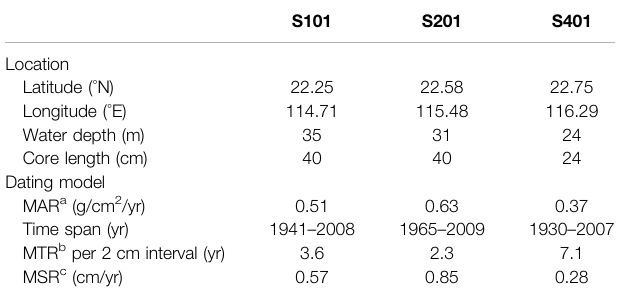
TABLE 1 | Information of the three sediment